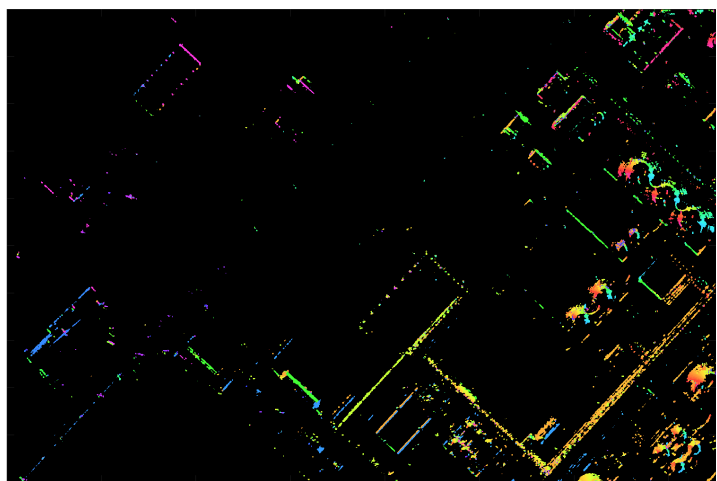
Figure 12. The scattering direction estimation result obtained by Rayleigh approach.